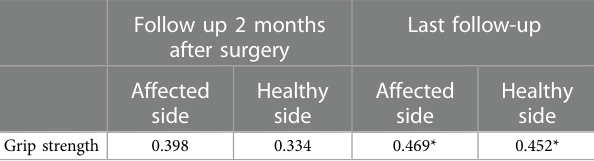
TABLE 2 Pearson correlation coef fi cient results of the correlation between maximum grip strength and maximum RMS of super fi cial digital fl exor muscle.